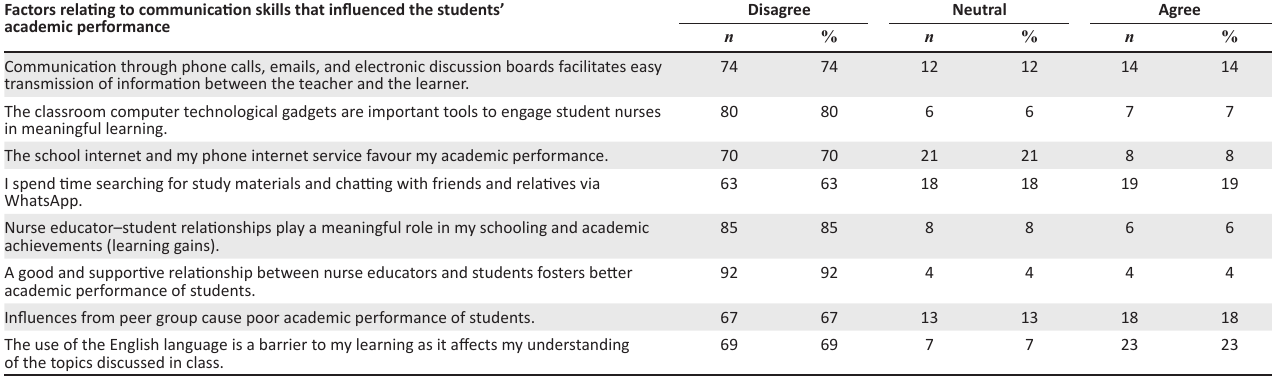
TABLE 1: Student nurses’ perceptions of factors relating to communication skills that influenced their academic performance. Factors relating to communication skills that influenced the students’ academic performance